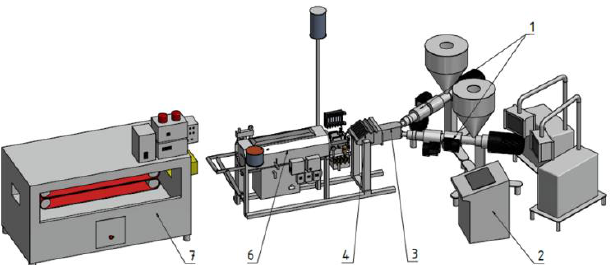
Figure 2. Schematic representation of the co-extrusion line used: 1. extruders; 2. temperature control box; 3. feeding block; 4. co-extrusion die; 5. vacuum calibration and water-cooling tank; 6. haul-off device.